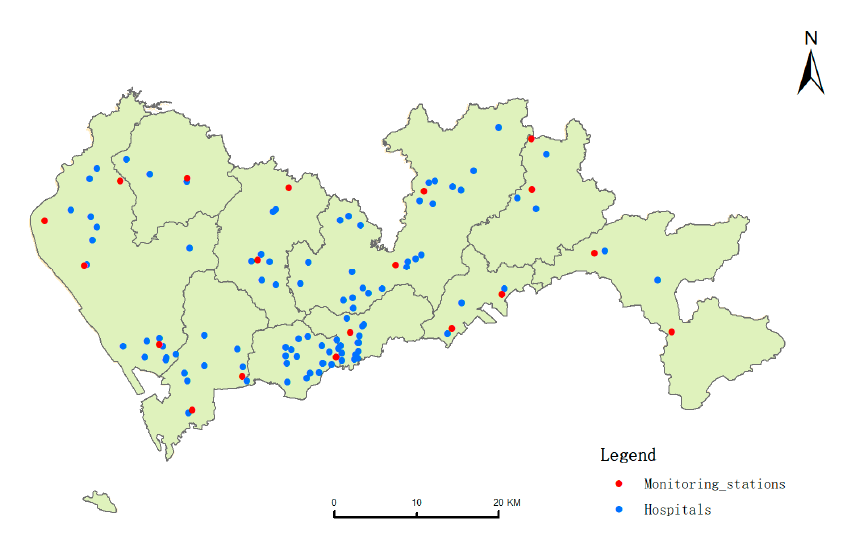
Figure 1. Distribution of 98 hospitals and 19 air quality monitoring stations in Shenzhen.